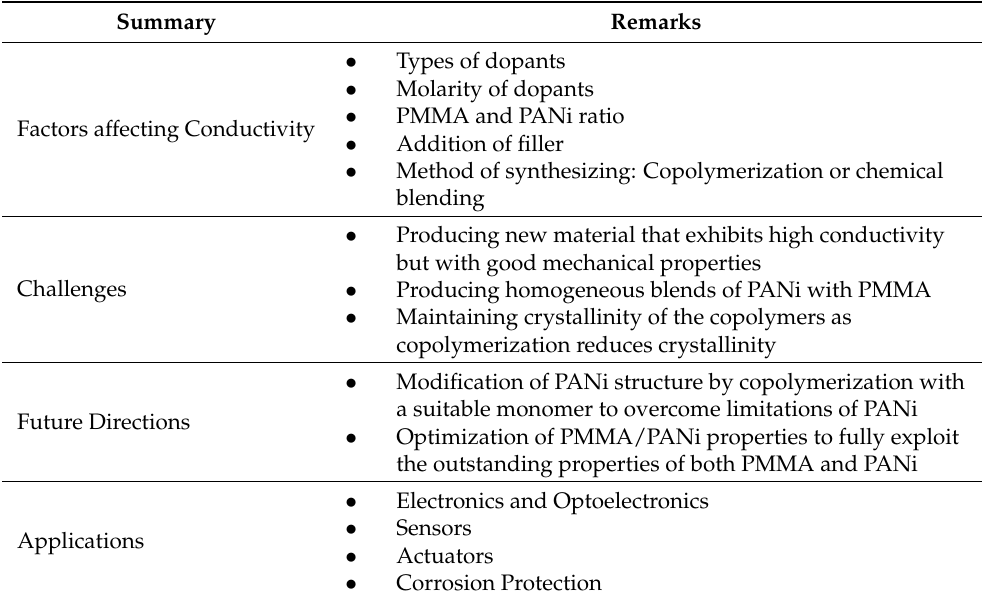
Table 12. Summary of conductivity studies for conducting